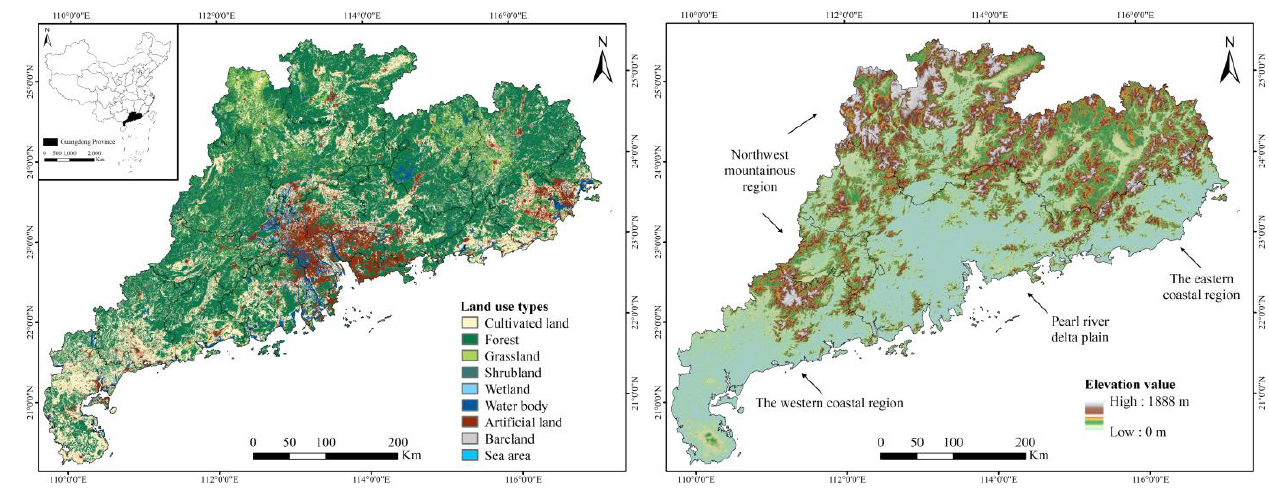
Figure 1. Status of land use (2020) and elevation of the study area.